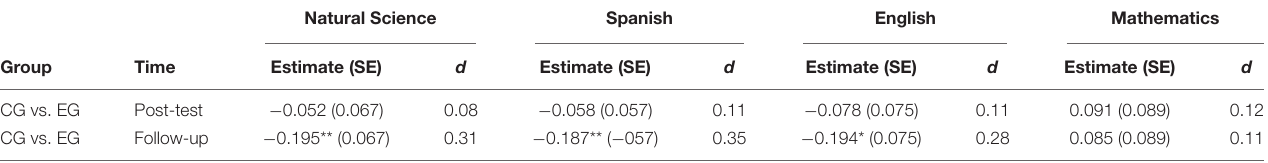
TABLE 4 | Comparisons of group × time least-squares means for each dependent variable (subject) and theirs standardized effect size. Natural